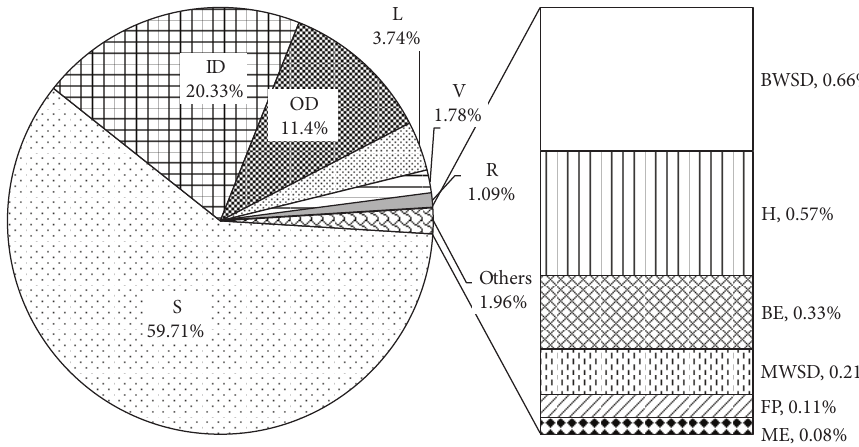
F 1: GHG emission from construction material of construction stage.